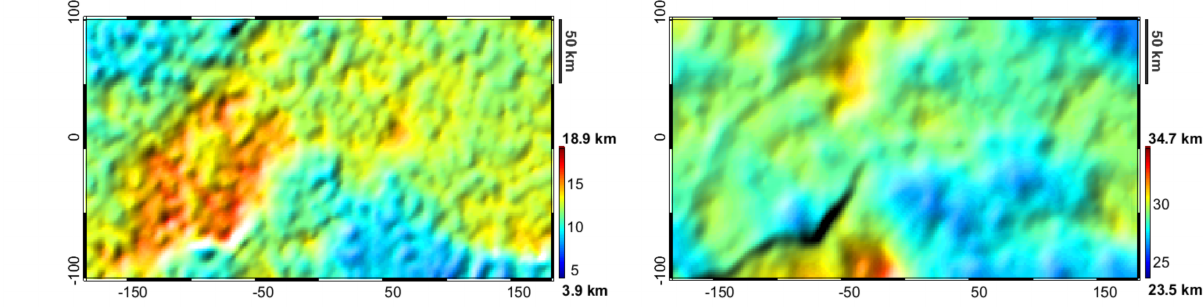
Figure 8. Scenario 1 inversion: Estimated depth to basement ( left ) and Moho depth ( right